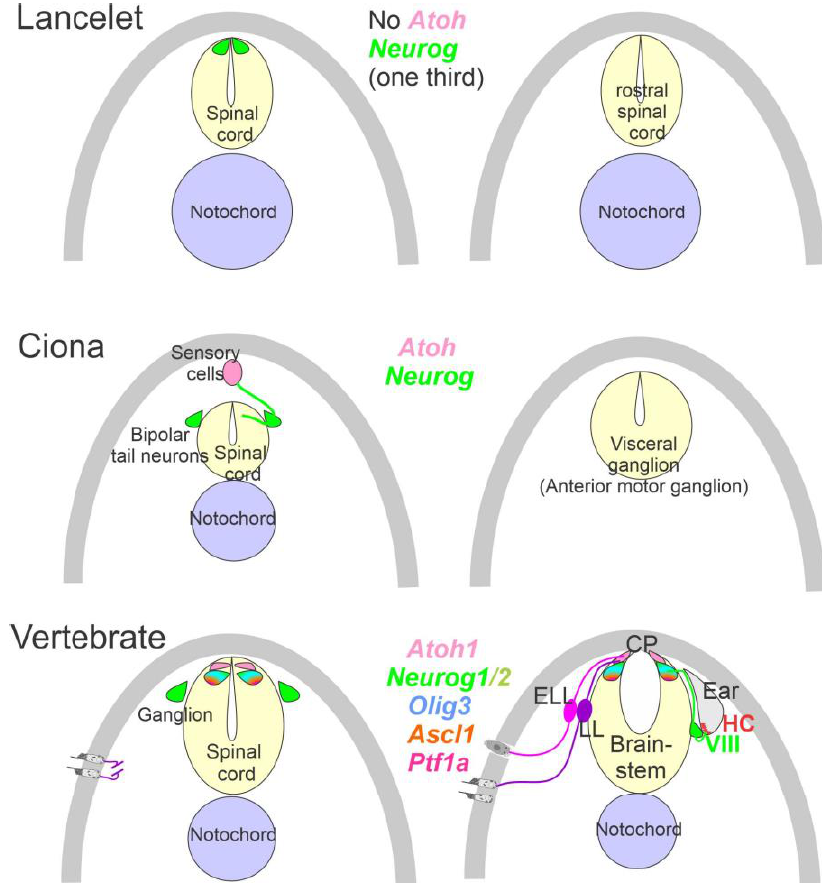
Figure 2. Neurons require Neurog expression. Lancelets have a limited description of bHLH genes that are characterized in the more caudal spinal cord, which is positive for Neurog . Note that the lancelet has no Atoh bHLH gene. Ciona has at least 6 bHLH genes expressed in sensory cells that are innervated by bipolar tail neurons which extend to reach the visceral ganglion for interactions. Atoh and Neurog genes are described in Ciona associated with the spinal cord. Vertebrates have dorsal root ganglia that depend on Neurog1/2 , which is also expressed in Atoh1 and Neurog1 of the spinal cord. The brainstem is innervated by electroreceptor (ELL) and lateral line fibers (LL) that extend to innervate migration populations of LL and some ELL). The ear is unique in vertebrates, which give rise to the VIII ganglia that innervate more ventral nuclei compared to LL and ELL projections to reach Atoh1 . CP, choroid plexus. Modified after